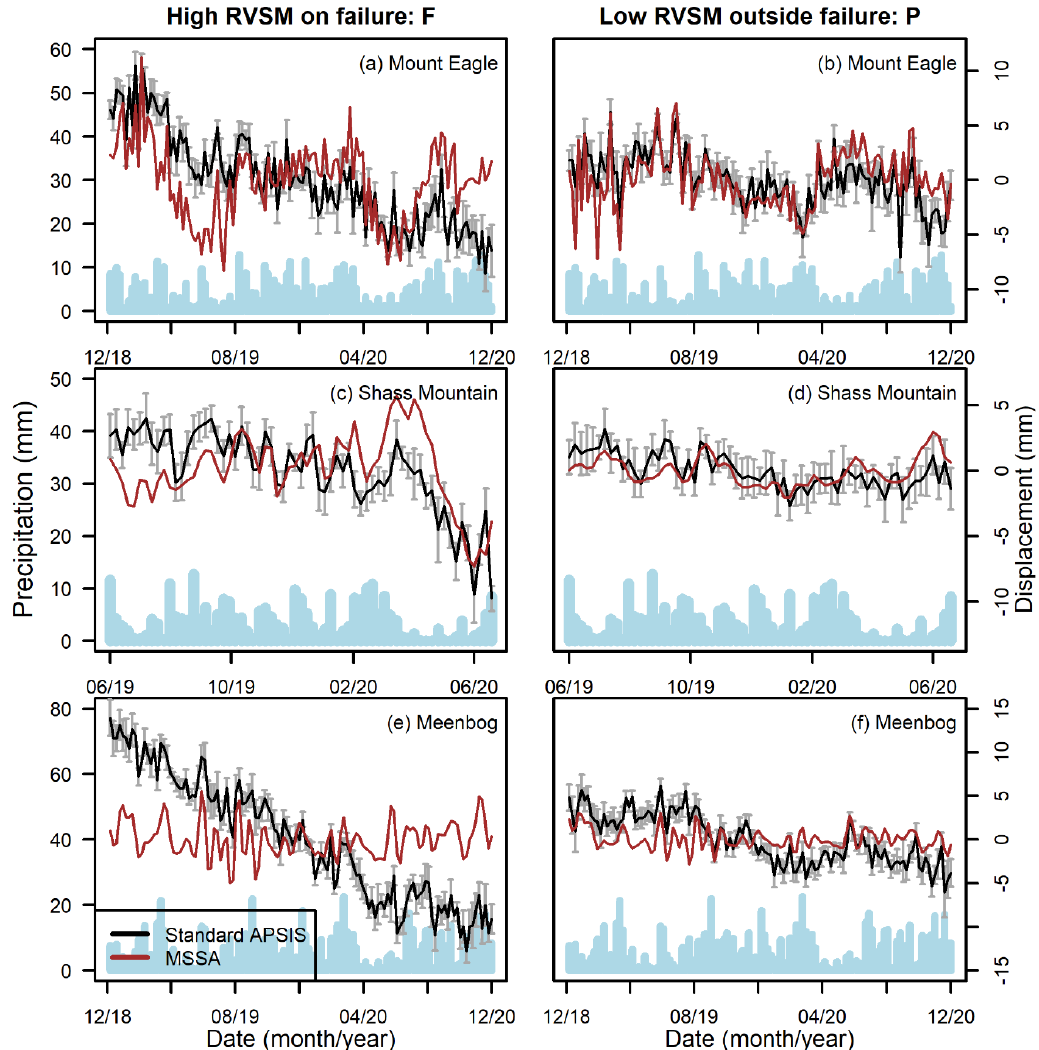
Figure 5. Time series of daily precipitation (light blue histogram), the average surface motion for an area of high RVSM (F) within the area of the peat slide, and for an area of low RVSM (P) in neighbouring blanket bog outside the area of the peat slide (Figure 2), for the Mount Eagle (a–b), Shass Mountain (c–d) and Meenbog slides (e–f). Surface motion from both the standard APSIS and the MSSA (upscaled ×2 for visualisation) results is